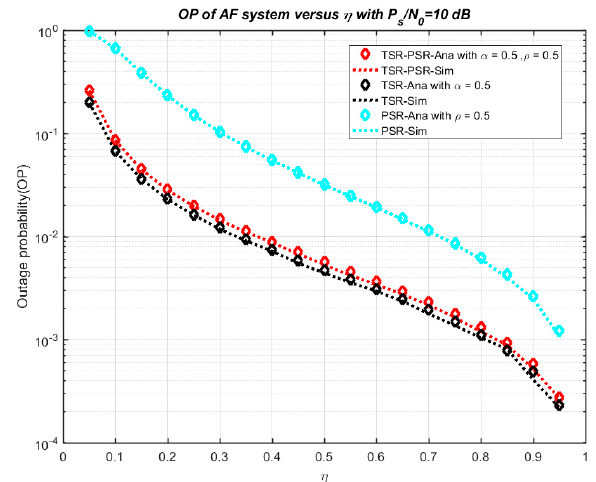
Figure 3. Outage probability versus η .